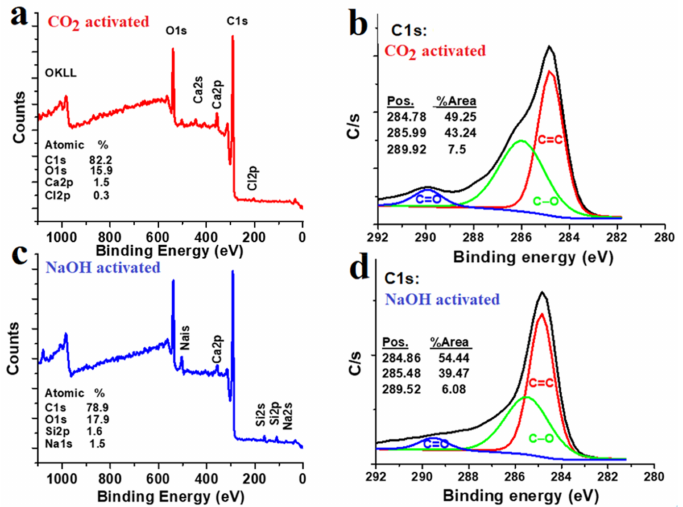
Figure 3. XPS full-survey and C 1s profiles; ( a , b ) for the physically CO 2 -activated carbon; ( c , d ) the chemically NaOH-activated carbon.